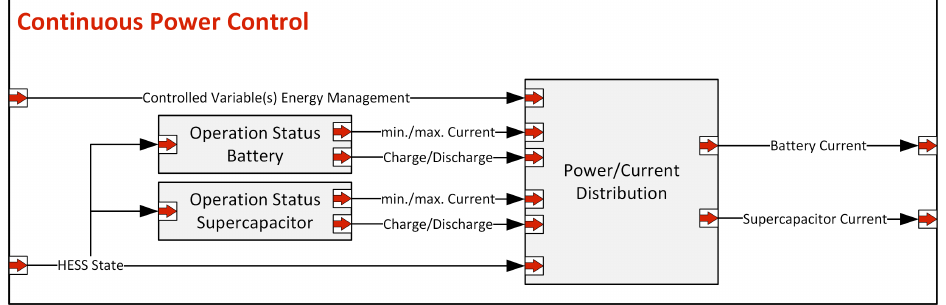
Figure 2. Concept for continuous power